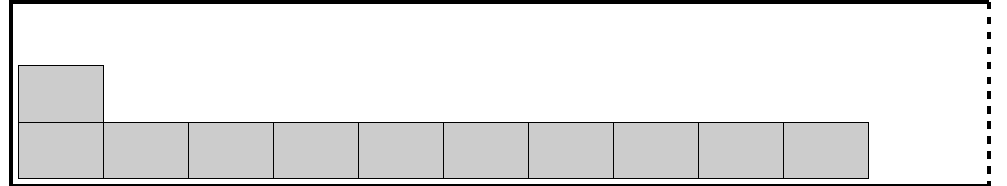
Figure 2. Illustration of stacking with R = 3 and L = 11 that may violate stability restrictions if heavy goods is